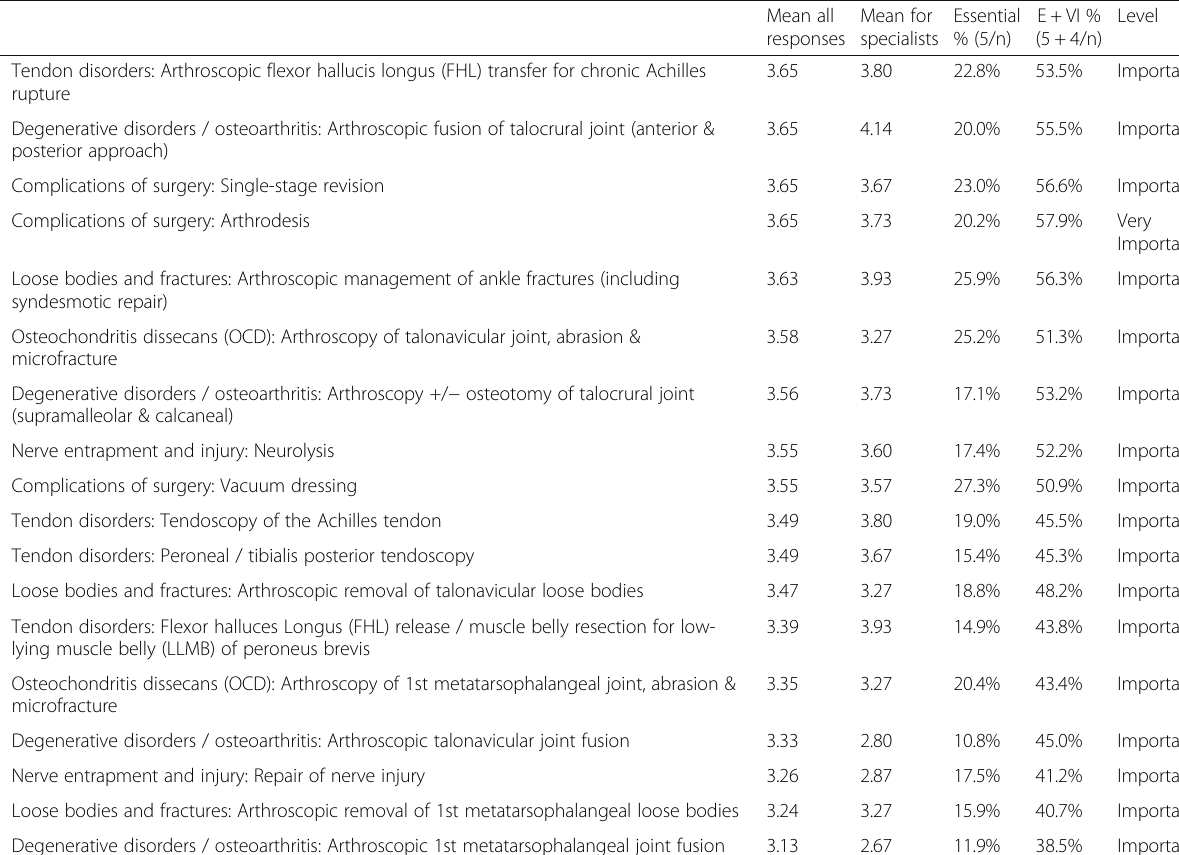
Mean all Mean for Essential E + VI % Level responses specialists % (5/n) (5 + 4/n)